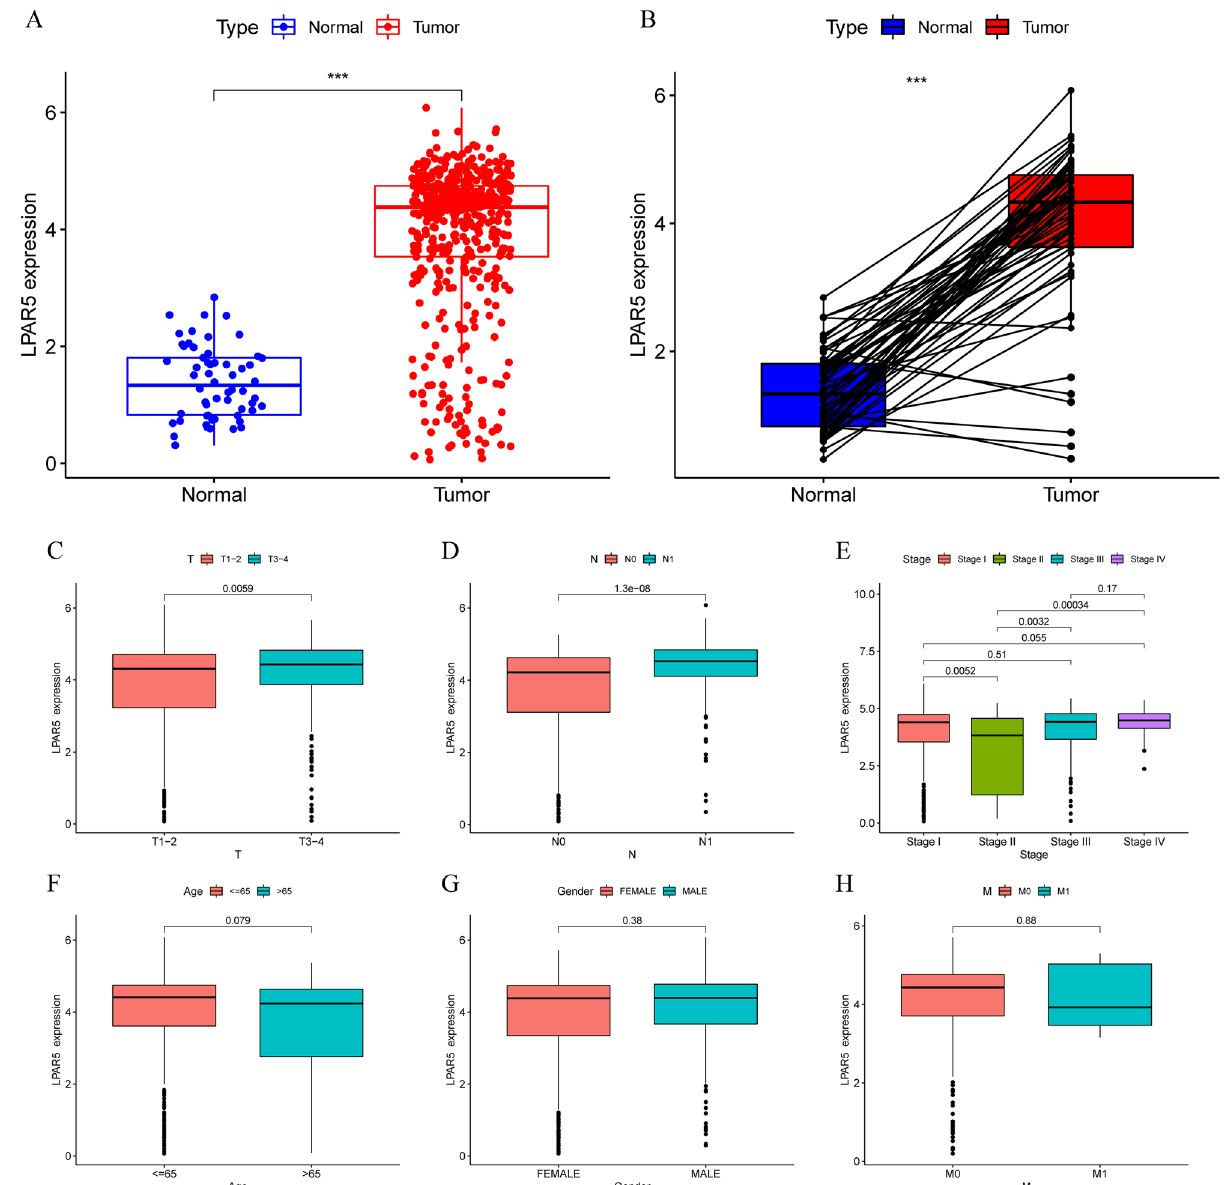
Figure 1. Expression of LPAR5 in normal thyroid tissues and tumor tissues and six clinicopathological features of patients with PTC. ( A ) LPAR5 expression was significantly different in 58 normal tissues and 510 tumor tissues. ( B ) LPAR5 expression between the paired tumor tissues and normal tissues in the same sample. ( C – E ) The expression level of LPAR5 was significantly different in T stage, N stage, and stages I–IV. ( F – H ) The expression level of LPAR5 was not significantly different in age, gender, and M stage. [Figures created by R, version